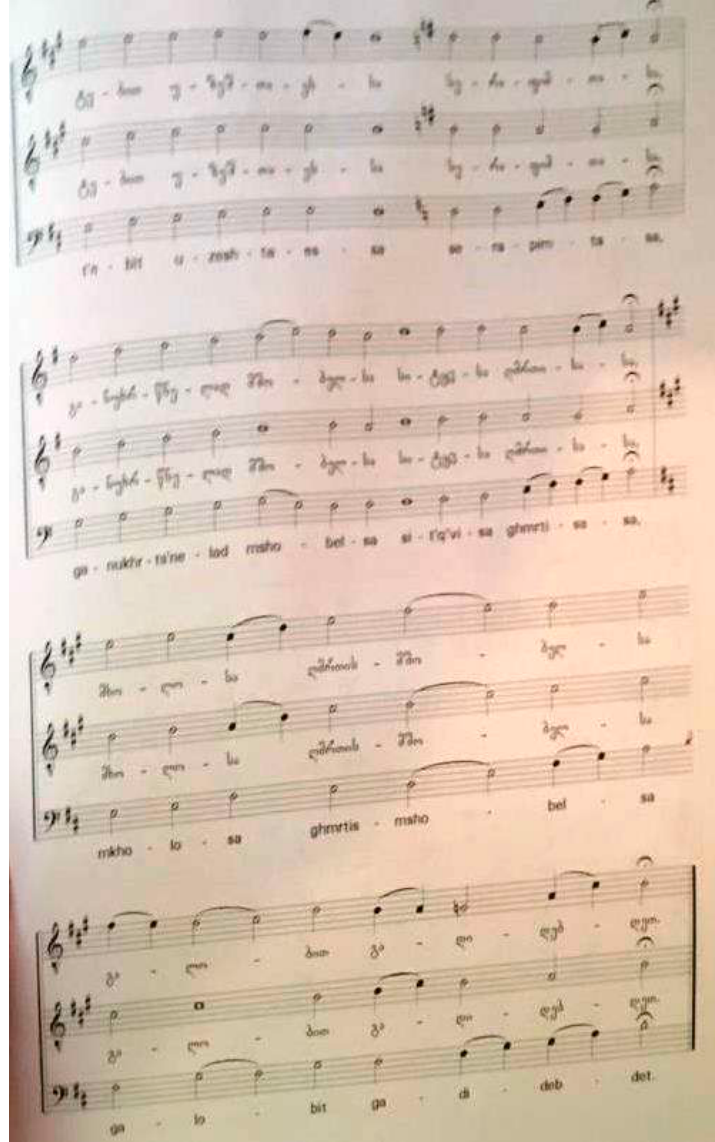
Figure 14. It Is Truly Meet; Gelati School (Chkhikvishvili and Razmadze 2010).